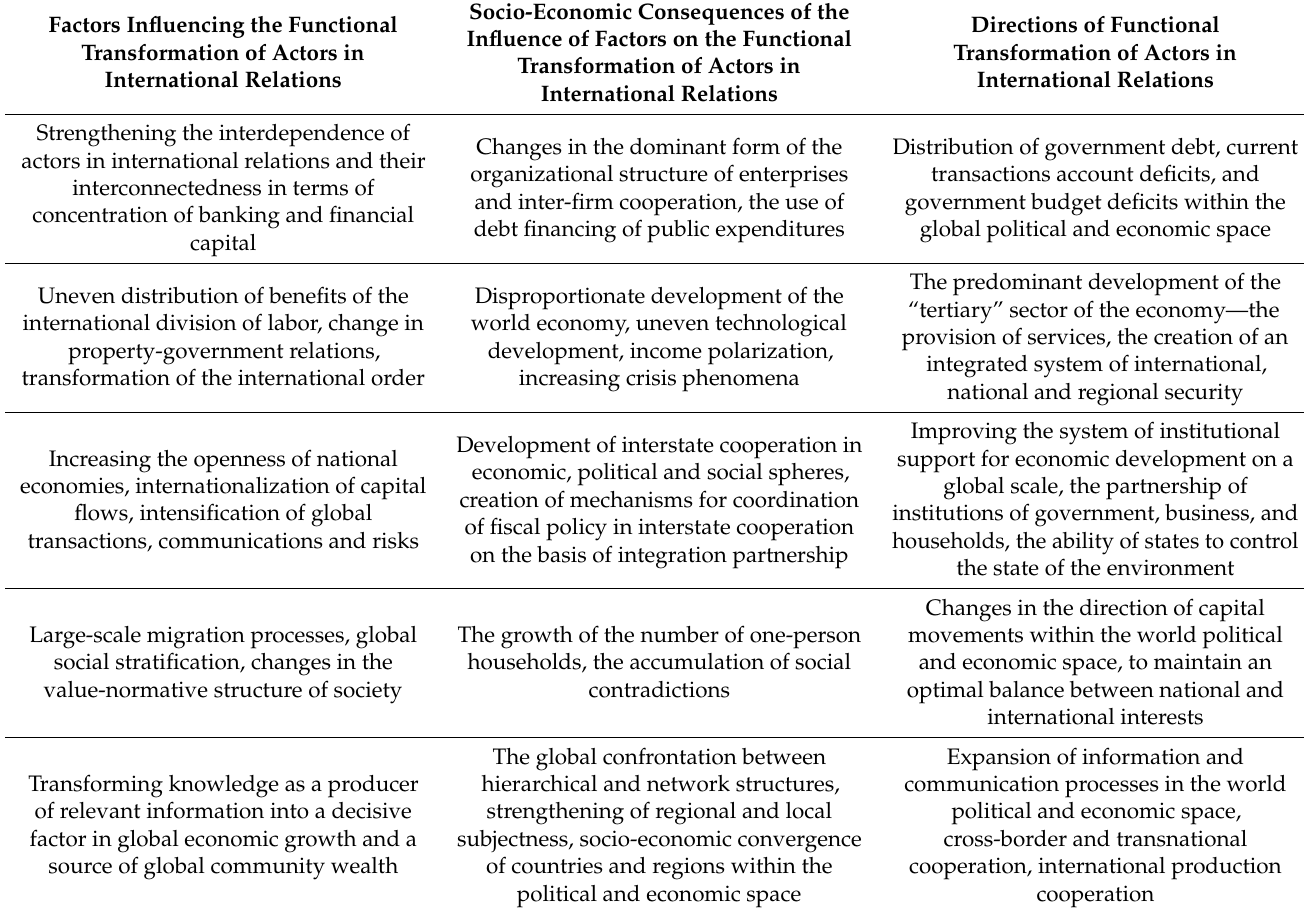
Table 2. Structural components of the functional transformation of actors in international relations within the global political and economic